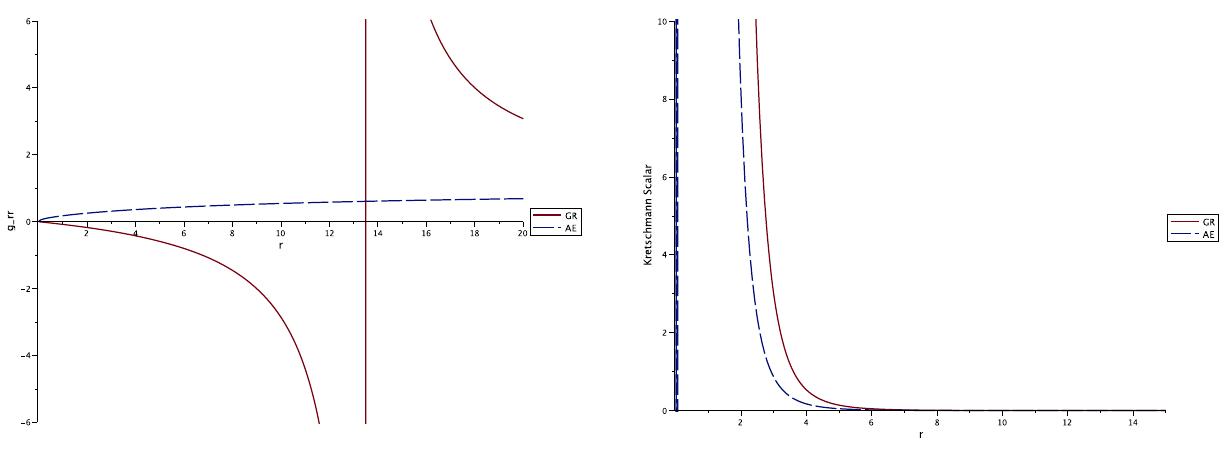
Fig. 4 Plot of the metric component g rr , for EA parameters c 14 = 48 / 25, | γ | = 1 and an arbitrary Schwarzschild mass M = 27 / 4. The continuousredlinerepresentstheGRSchwarzschildmetric.Thedashed blue line represents the EA solution. Calculating the limit r → +∞ we obtain g rr = e 2 B → 1, as we can see in this figure. Calculating the limit r → r sing 1 = 0 we obtain g rr = e 2 B → 0, as we can see in this